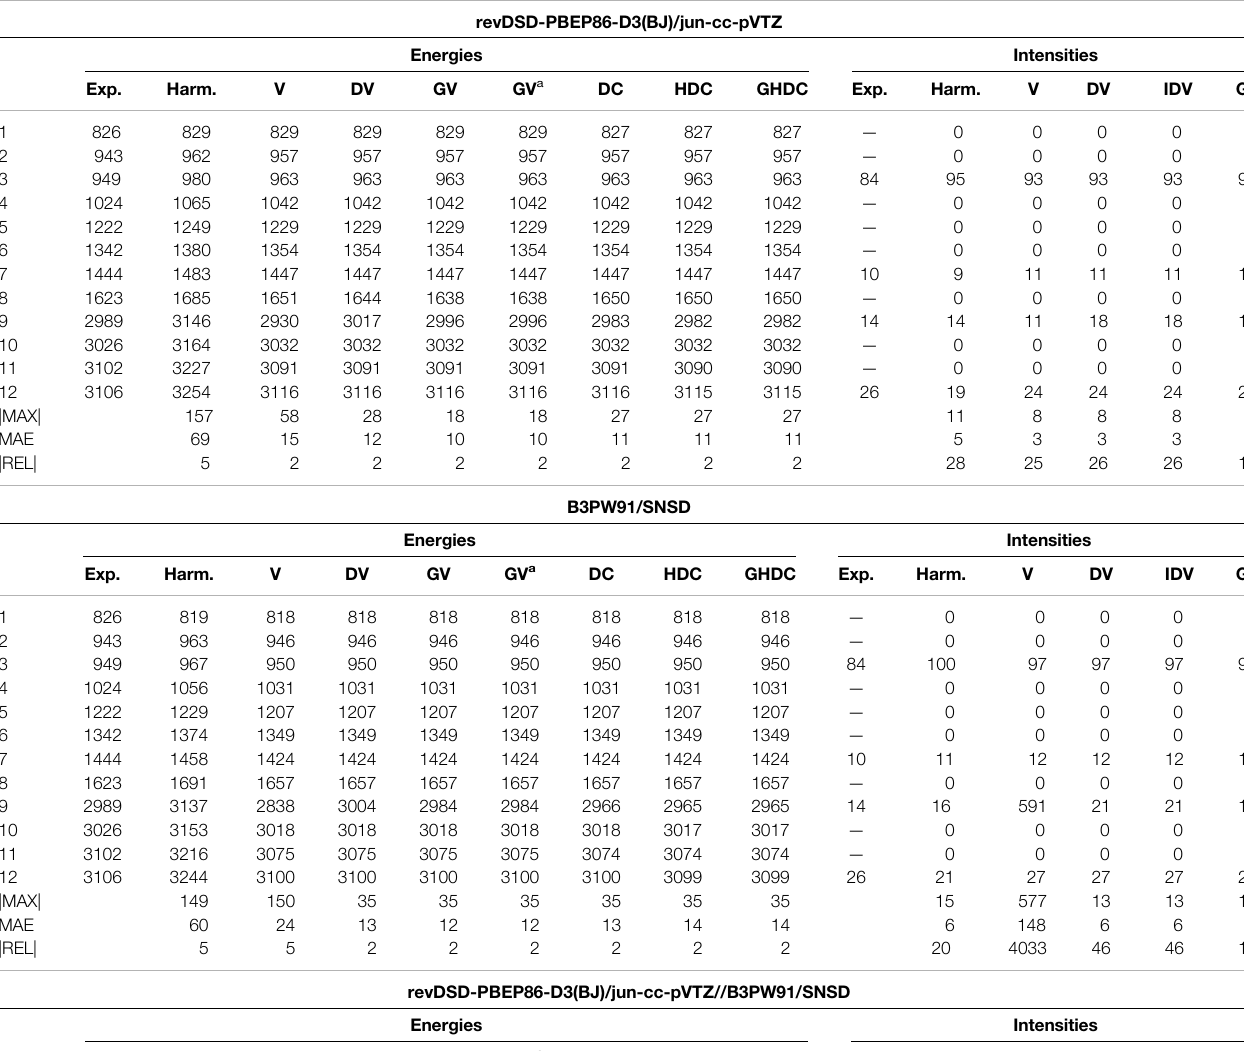
TABLE 3 | Harmonic and anharmonic vibrational energies (in cm − 1 ) and intensities (km/mol) of ethylene computed at the revDSD-PBEP86-D3(BJ)/jun-cc-pVTZ, revDSD- PBEP86-D3(BJ)/jun-cc-pVTZ and hybrid revDSD-PBEP86-D3(BJ)/jun-cc-pVTZ//B3PW91/SNSD levels of theory and with different VPT2 schemes, VPT2 ( V ), DVPT2 ( DV ),IDVPT2( IDV ),GVPT2( GV ),DCPT2( DC ),HDCPT2( HDC ),GHDCPT2( GHDC ).Themaximum(MAX|)andmean(MAE)absoluteerrors,aswellasthemaximumrelative error weighted by the reference value (|REL|, given in %) are reported with respect to experimental data from (Nakanaga et al.,